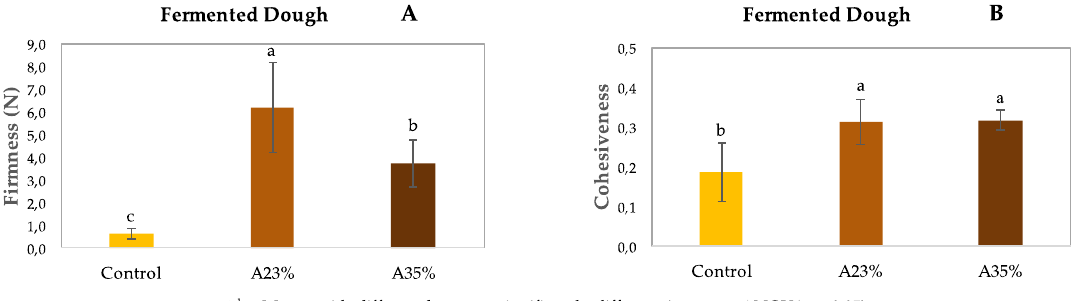
Figure 3. Firmness (A) and cohesiveness (B) of GF doughs (control, A23% and A35%).